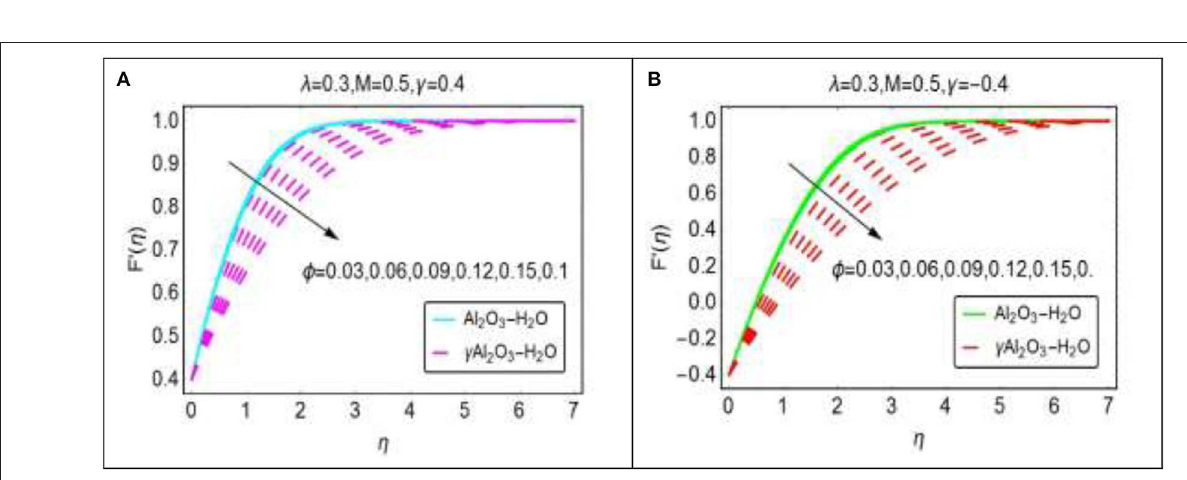
FIGURE 4 | The effects of φ on dimensionless velocity F ′ ( η ) for (A) γ = 0.4, (B) γ = − 0.4.